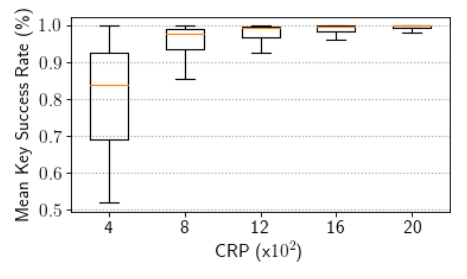
Figure 5: Mean key success rate of the ML model for a 128-SUM PUF based on measured frequency